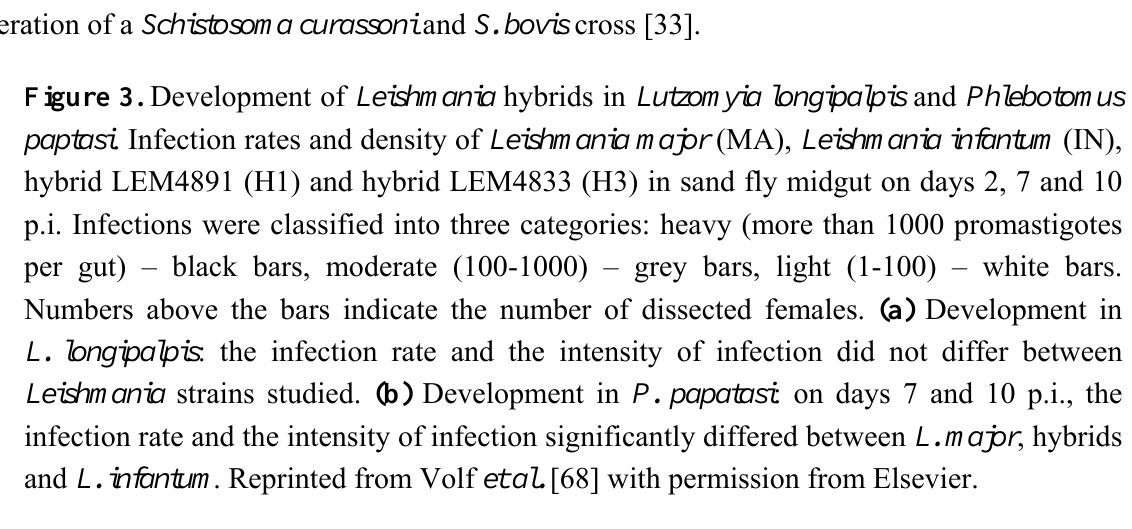
Figure 3. Development of Leishmania hybrids in Lutzomyia longipalpis and Phlebotomus paptasi . Infection rates and density of Leishmania major (MA), Leishmania infantum